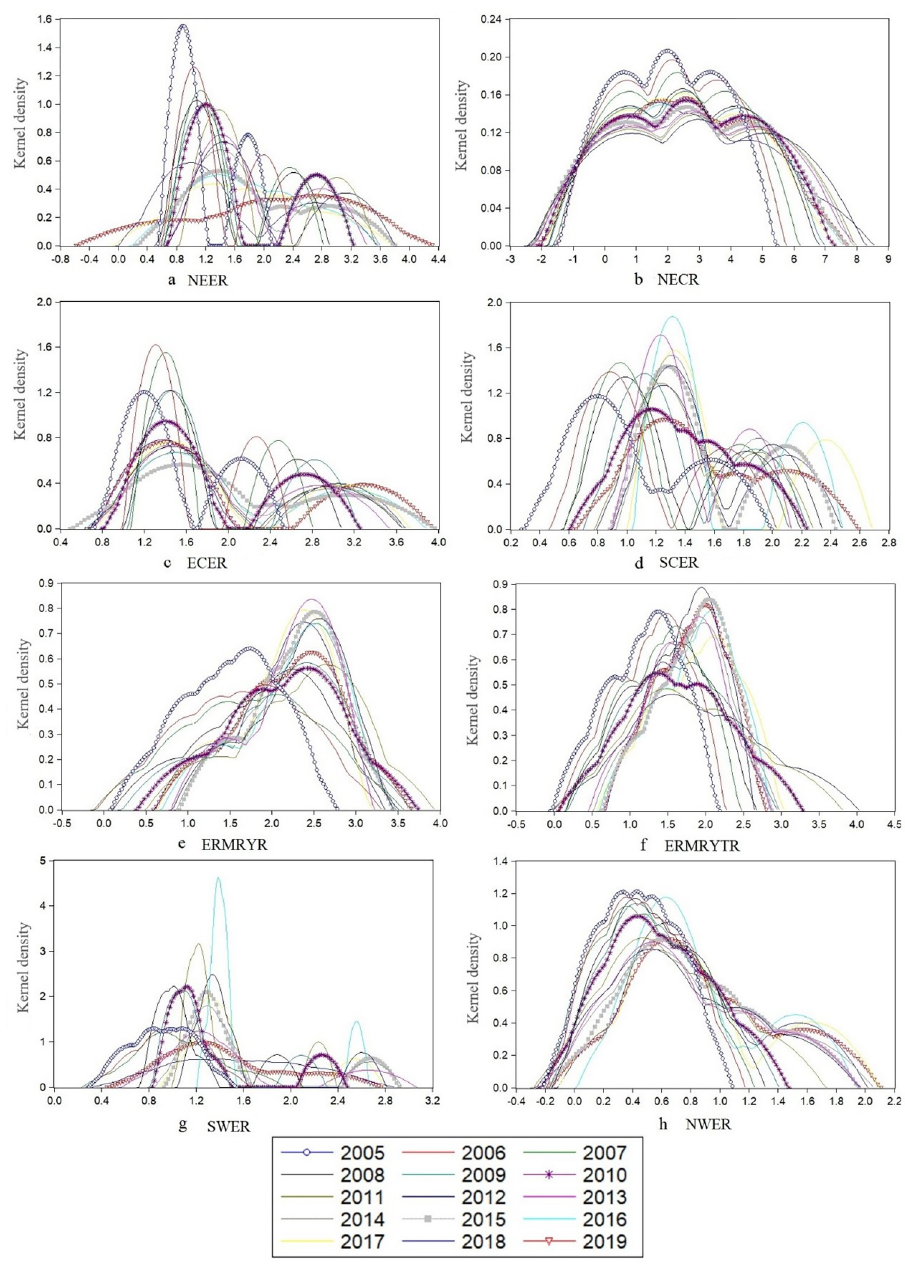
Fig 5. Temporal and spatial evolution trend of carbon emissions in China’s eight economic